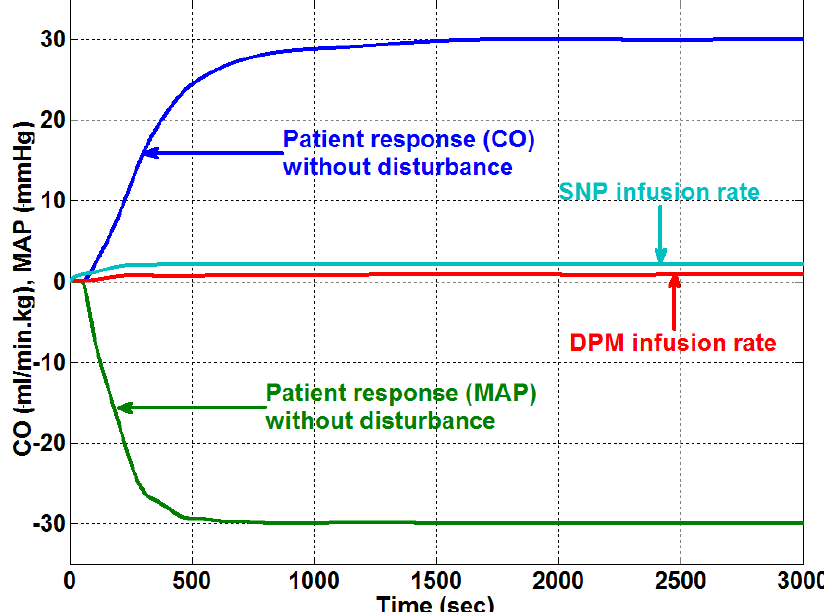
Figure 11: Nominal response without disturbance when set point changes are +30 for CO and -30 for MAP